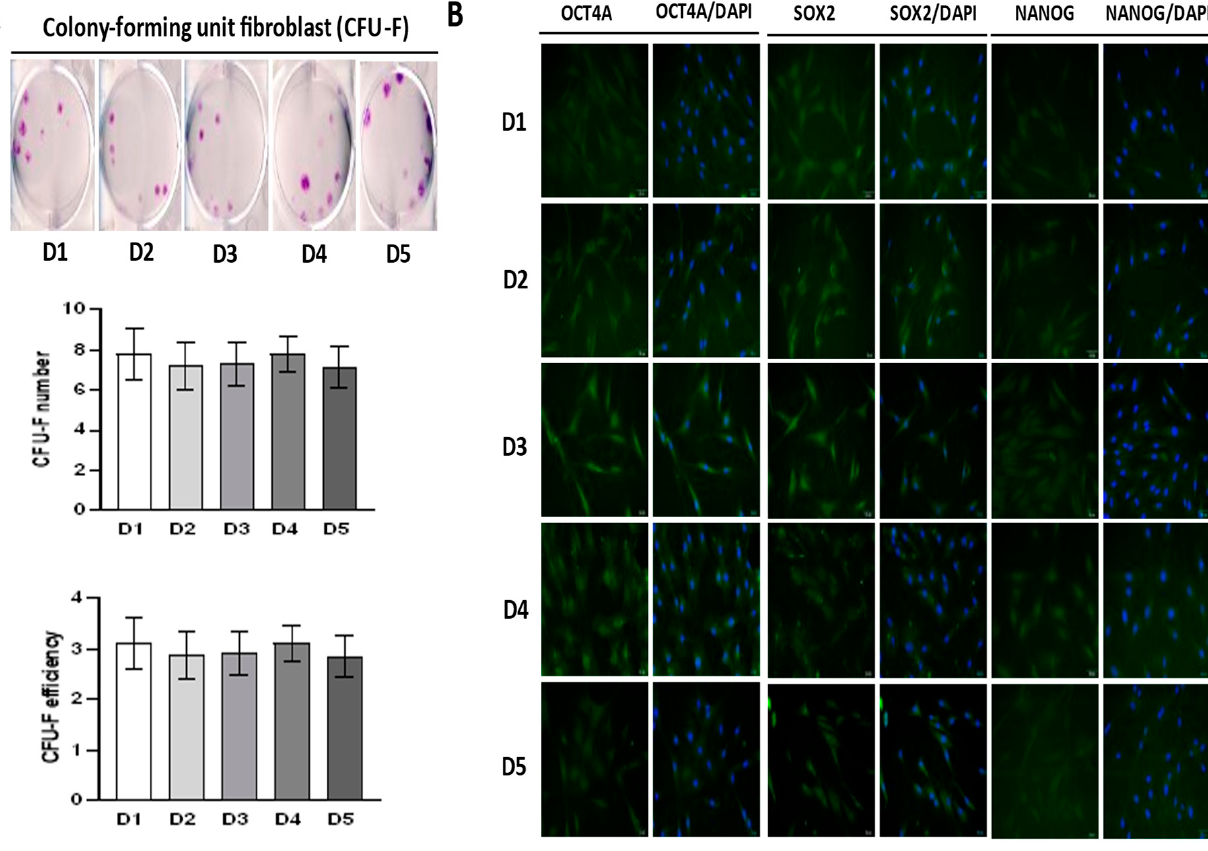
Figure 3. Clonogenic capacity and expression of pluripotency-associated markers in BM-MSCs. ( A ). Representative images of colony-forming unit–fibroblast (CFU-F) stained by crystal violet are shown. CFU-F number and efficiency (number of colonies relative to number of seeded cells) of BM-MSCs are presented as mean ± SEM of three independent experiments. ( B ) Expression of pluripotency-associated transcription factors (OCT4, SOX-2 and NANOG) determined by indirect immunofluorescence labeling with FITC-conjugated corresponding secondary antibodies. Cell nuclei were stained with DAPI (4 ′ ,6-diamidino-2-phenylindole). Representative images are shown (scale bars: 50 µm).